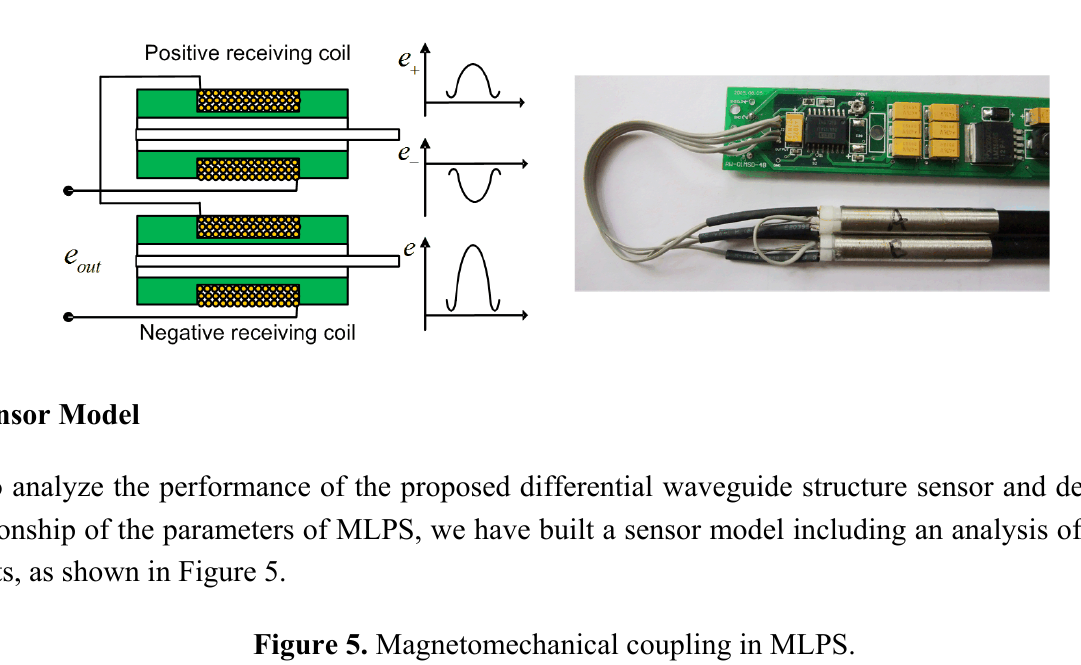
Figure 4. Structure with differential coils.